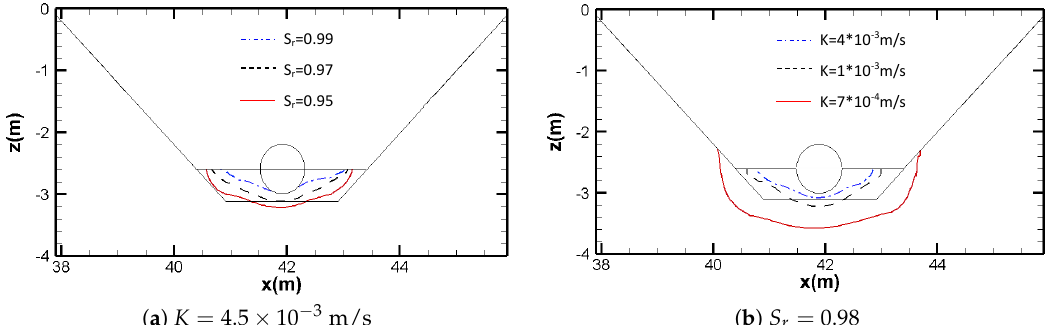
Figure 7. Distribution of the liquefaction depth around the partially buried pipeline for variable degree of saturation and permeability.